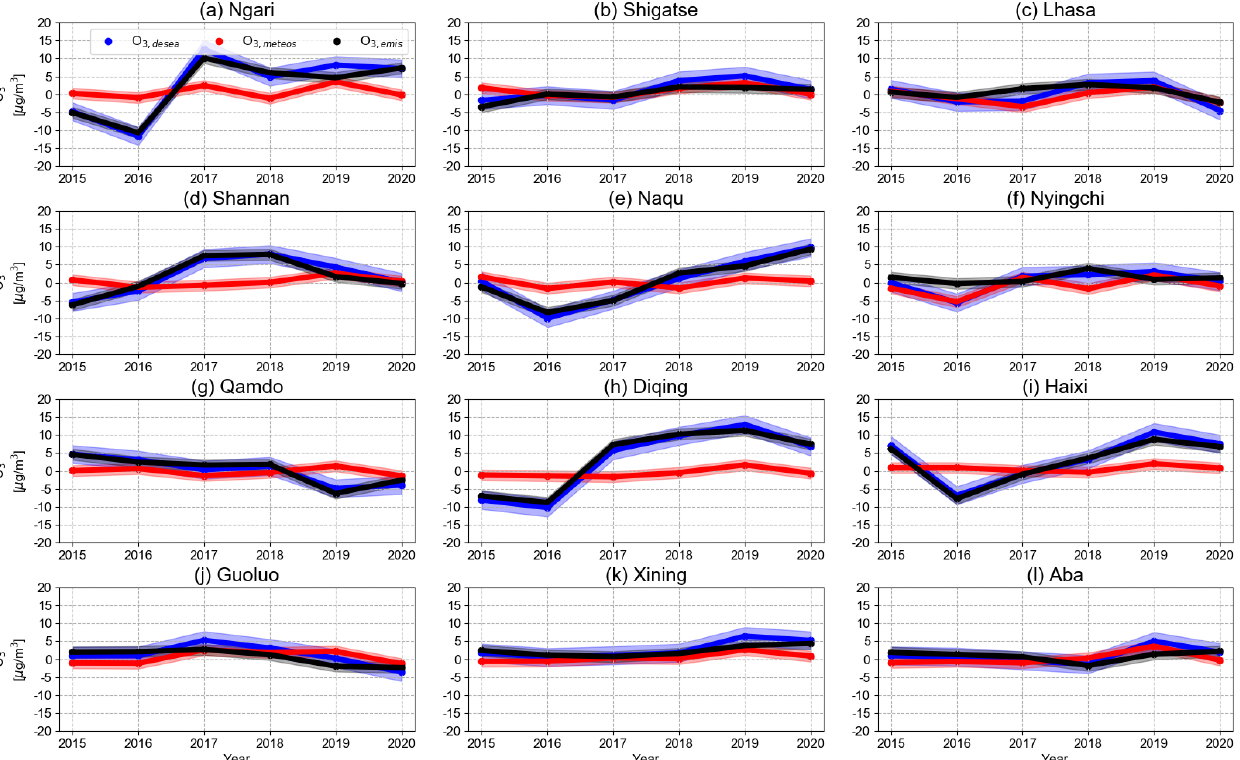
Figure 8. Annual mean surface ozone anomalies (O 3 , anomalies , blue dots and lines) along with meteorology-driven portions (O 3 , meteo , red dots and lines) and anthropogenic-driven portions (O 3 , emis , black dots and lines) in each city over the QTP. Bold curves and the shadows are annual mean values and the 1 σ standard variations